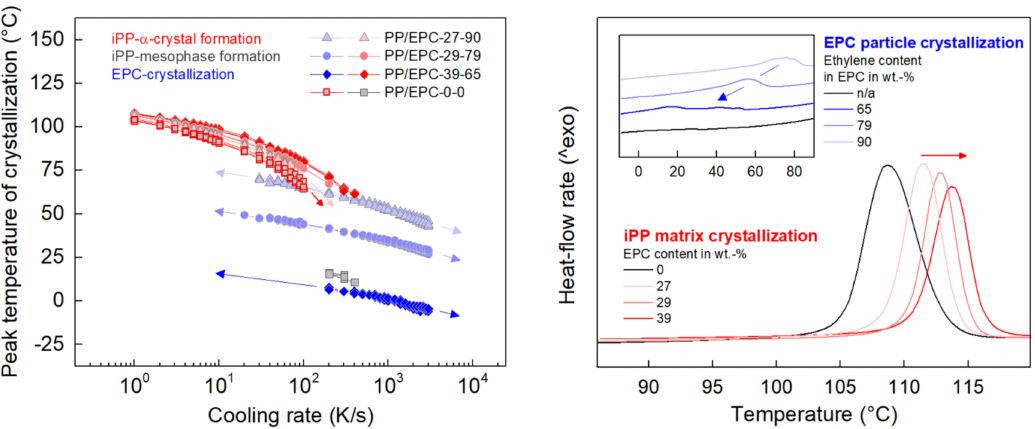
Figure 2. Peak crystallization temperature of iPP homopolymer and heterophasic iPP as a function of the cooling rate ( left ). DSC cooling scans, heat-flow rate as a function of temperature, of iPP and heterophasic iPP ( right ). Red, gray, and blue coloring of data refer to crystallization of iPP, mesophase formation of iPP, and crystallization of EPC particles, respectively. In the right graph, exothermic heat-flow rate is directed upwards, and the cooling rate was 20 K / min (0.33 K /